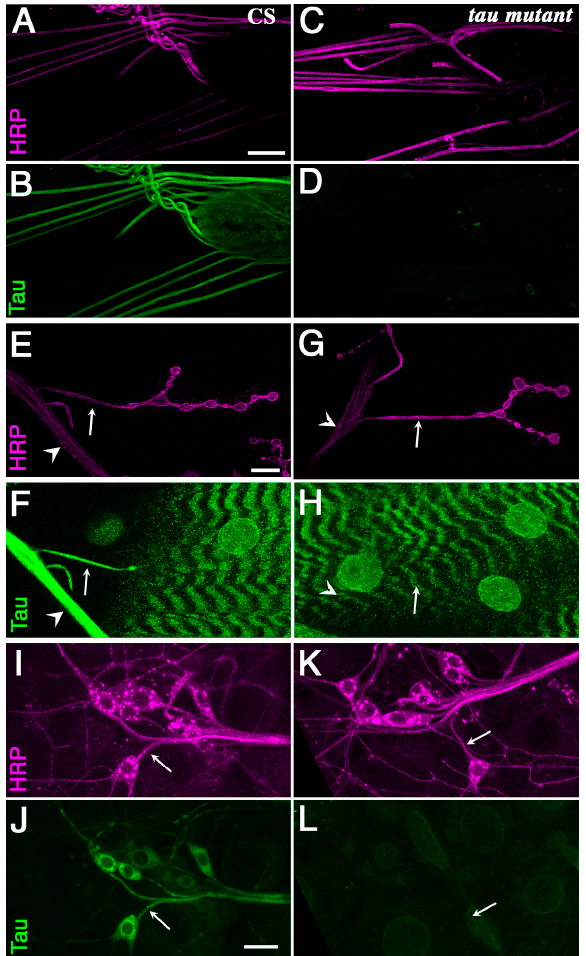
Figure 1. Tau is present in axons of motoneurons and sensory neurons. Anti Horse Radish Peroxidase (HRP) (magenta) and Tau (green) stainings of wild-type larvae ( A , B , E , F , I , J ) and tau ep3203 larvae ( C , D , G , H , K , L ). The anti-HRP antibodies are known to specifically label neurons in insects. ( A – D ) larval nerves exiting the brain are immunoreactive with the anti-Tau antibody [34] in wild-type animal, but not in tau mutants. Scale bar is 50 µ m. ( E – H ) Double HRP/Tau staining at the muscle 4 neuromuscular junction. There is some clear Tau staining in the axon (arrow) exiting the nerve (arrowhead) to innervate muscle 4 in wild-type larvae. There is no such staining in tau mutants. The staining observed in the underlying muscle is probably not specific since it does not disappear in tau mutants. Scale bar is 15 µ m. ( I – L ) Double HRP/Tau staining in the dorsal cluster of sensory neurons. There is some clear Tau immunoreactivity in the axons (arrows) of the sensory neurons. There is no Tau immunoreactivity in tau mutants. Scale bar is 15 µ m. CS: Canton